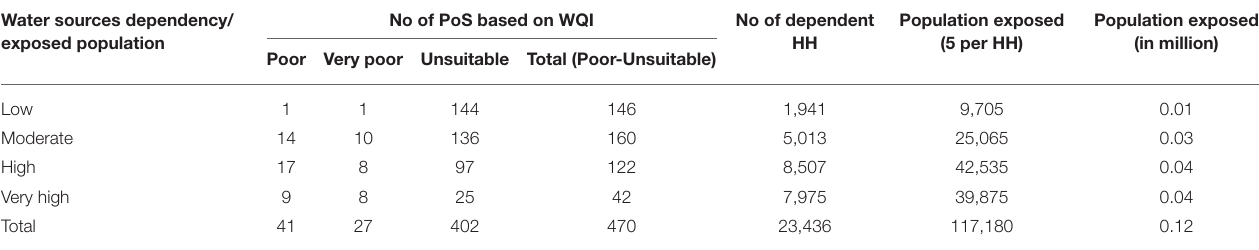
No of PoS based on WQI No of dependent